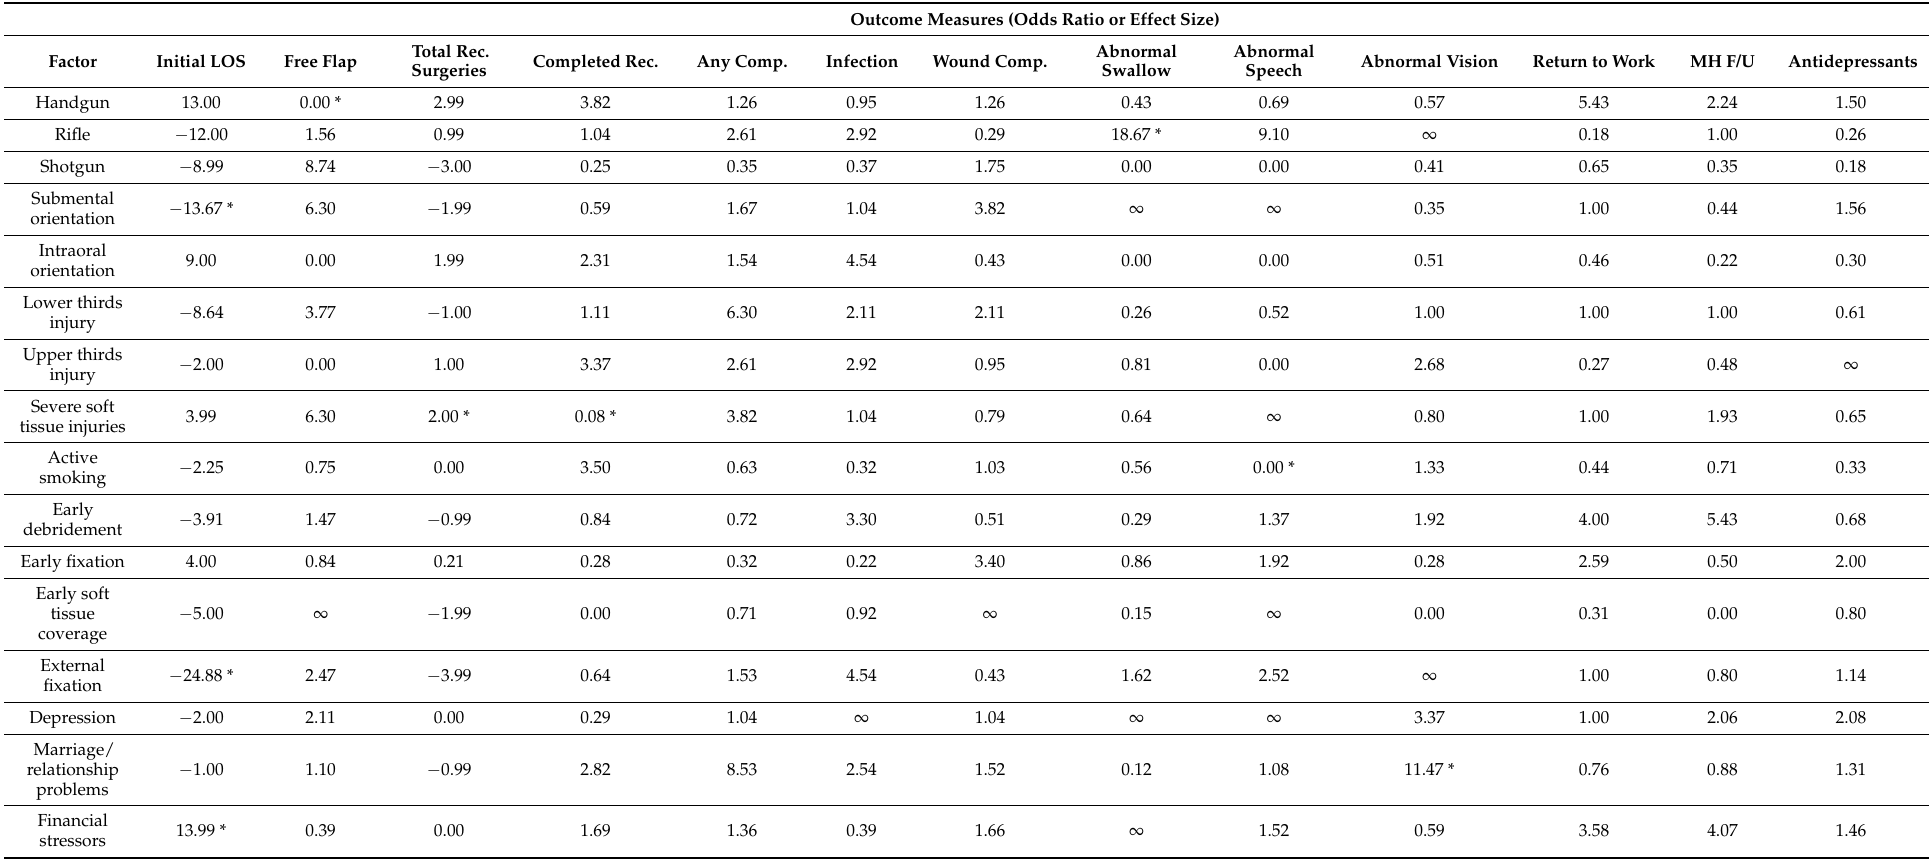
Table 7. Odds ratios and effect sizes of selected associations (N =